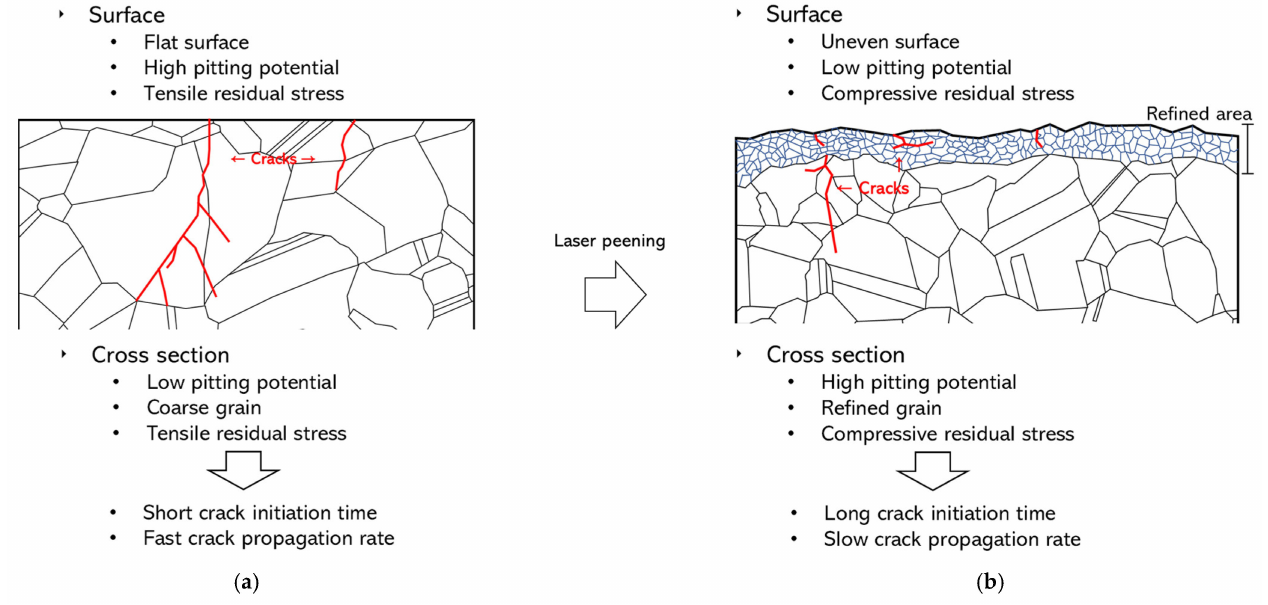
Figure 18. Proposed model of crack initiation and propagation of 304L stainless steel by laser shock peening: ( a ) non-peening; ( b ) laser shock